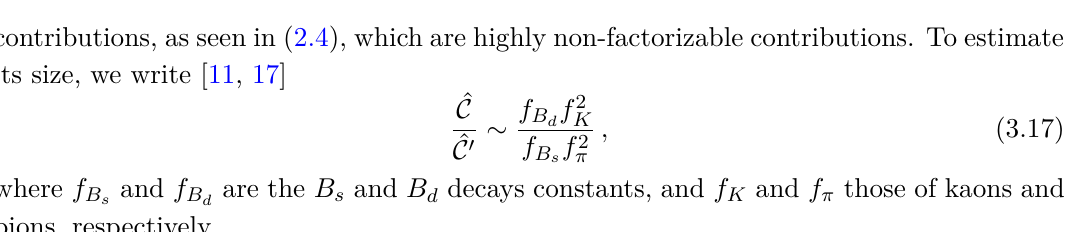
Table 3 . Experimental branching ratios in 10 − 6 for the B → h − h + modes taken from